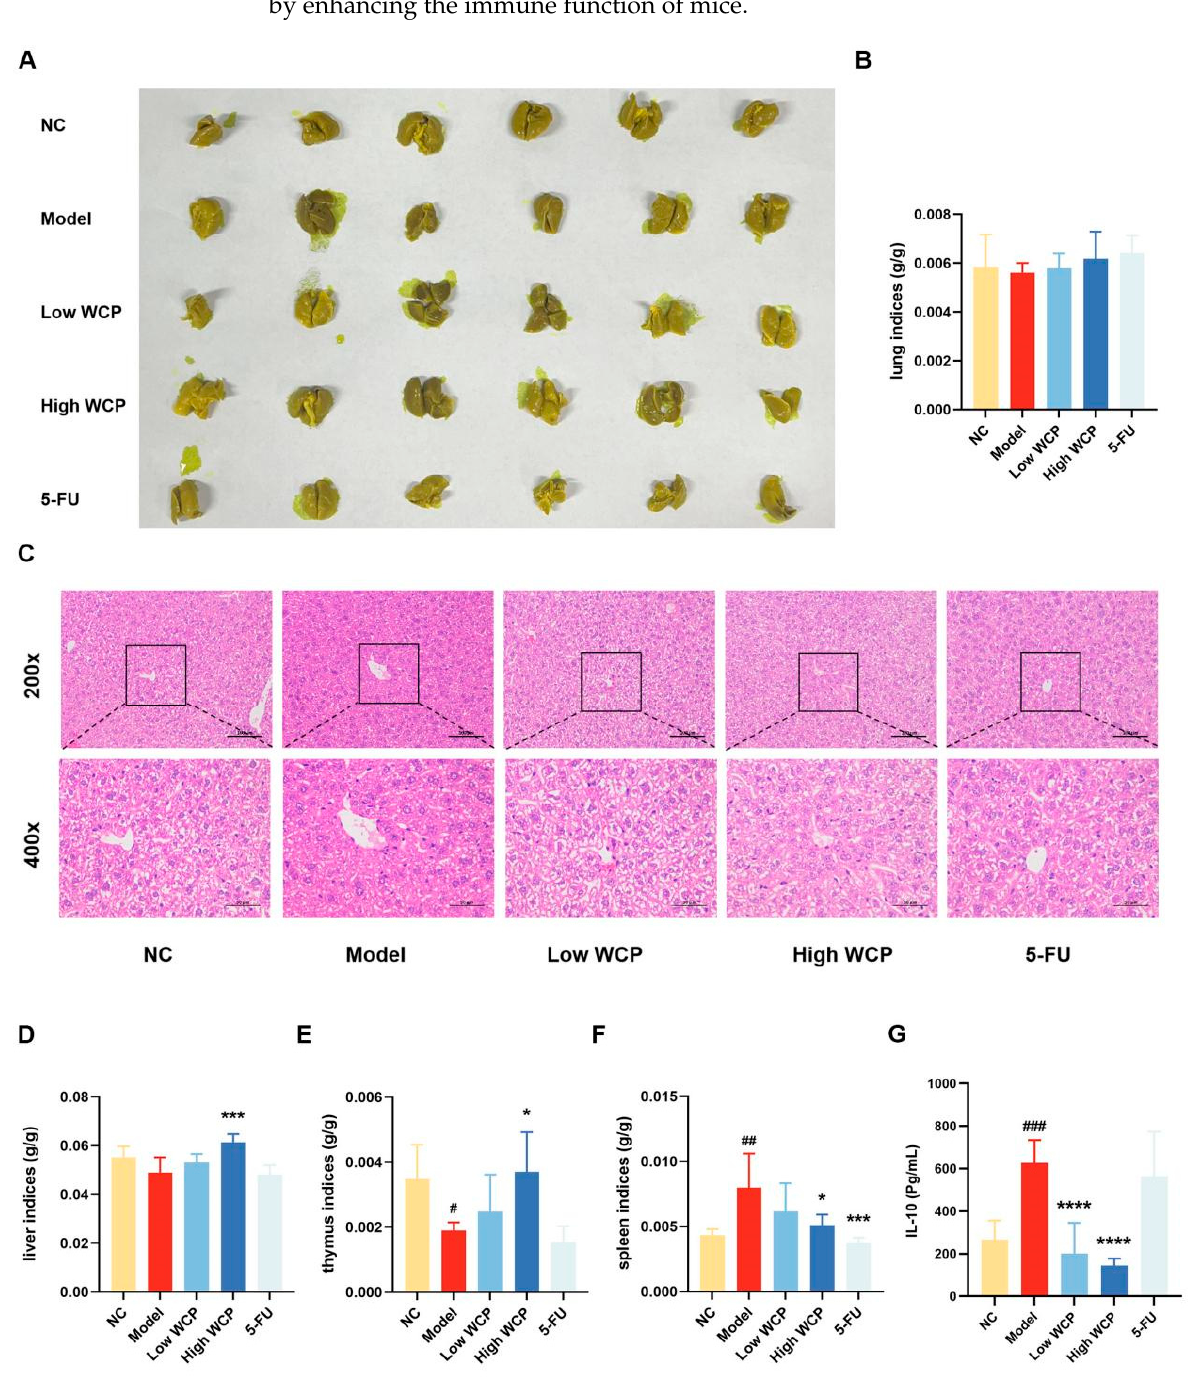
Figure 4. E ff ect of WCP on the liver, lung, organ indices, and IL-10. ( A ) Lungs fi xed with Bouins fi xative. ( B ) Lung indices. ( C ) HE staining of liver (200×, 400×, scale bar = 100 µm, 50 µm). ( D ) Liver indices. ( E ) Thymus indices. ( F ) Spleen indices. ( G ) Serum IL-10 concentration of H22-tumor-bear- ing mice. # p < 0.05, ## p < 0.01, ### p < 0.001 compared to NC group; * p < 0.05, *** p < 0.001, **** p < 0.0001 compared to model